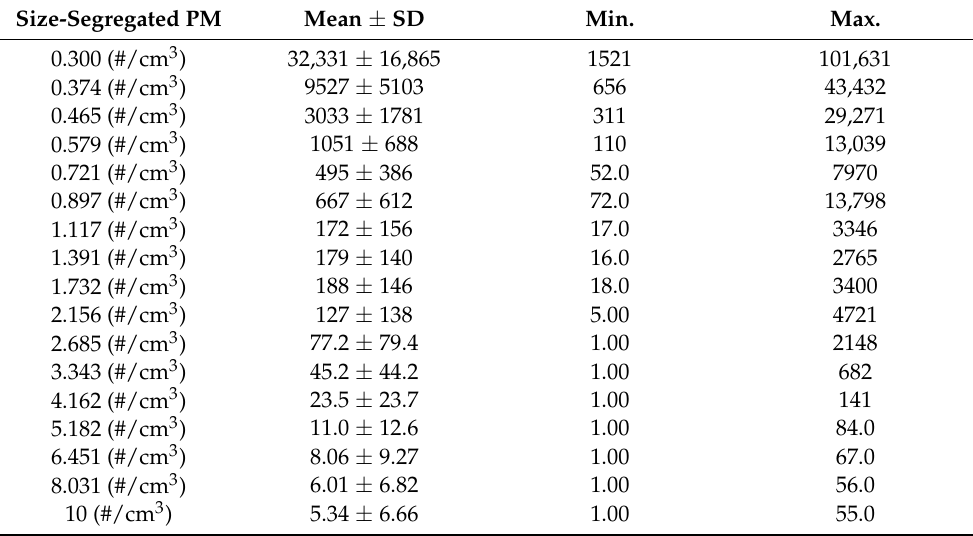
Table 2. Daily average statistics of particle number concentration (#/cm 3 ) for size-segregated PM (0.3–10 µ m) during the study period at the Port of Albany, New York. Size-Segregated PM Mean ± SD Min. Max. 0.300 (#/cm 3 ) 32,331 ± 16,865 1521 101,631 0.374 (#/cm 3 ) 9527 ± 5103